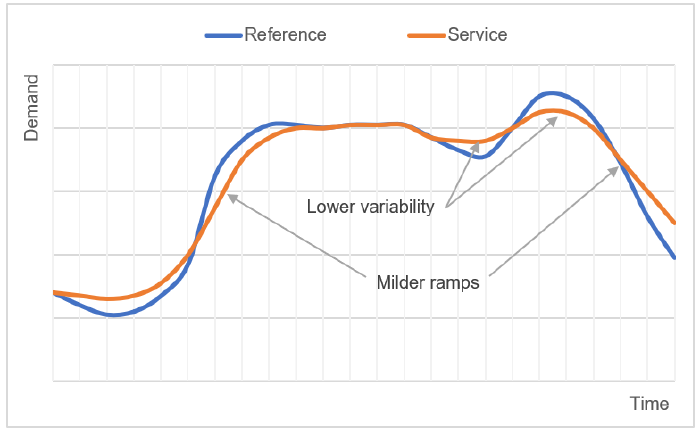
Figure 3. Load profile smoothing.